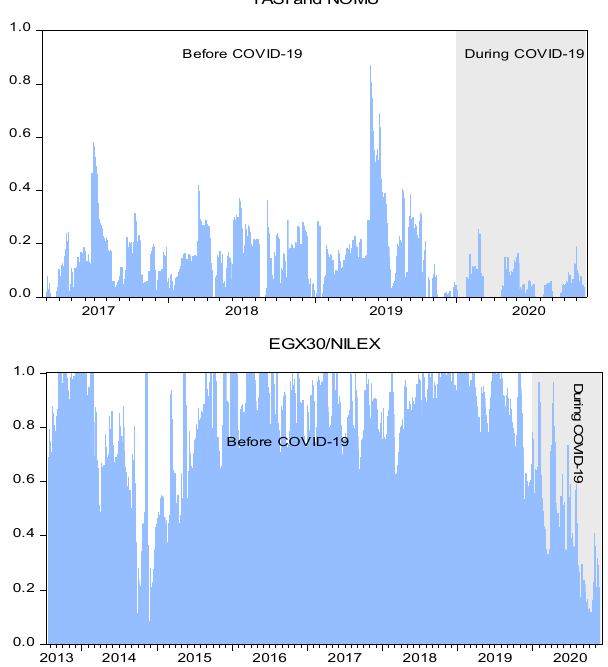
Figure 5. Time-varying portfolio weights computed from the VAR (1)-asymmetric DCC–GARCH (1,1) model.